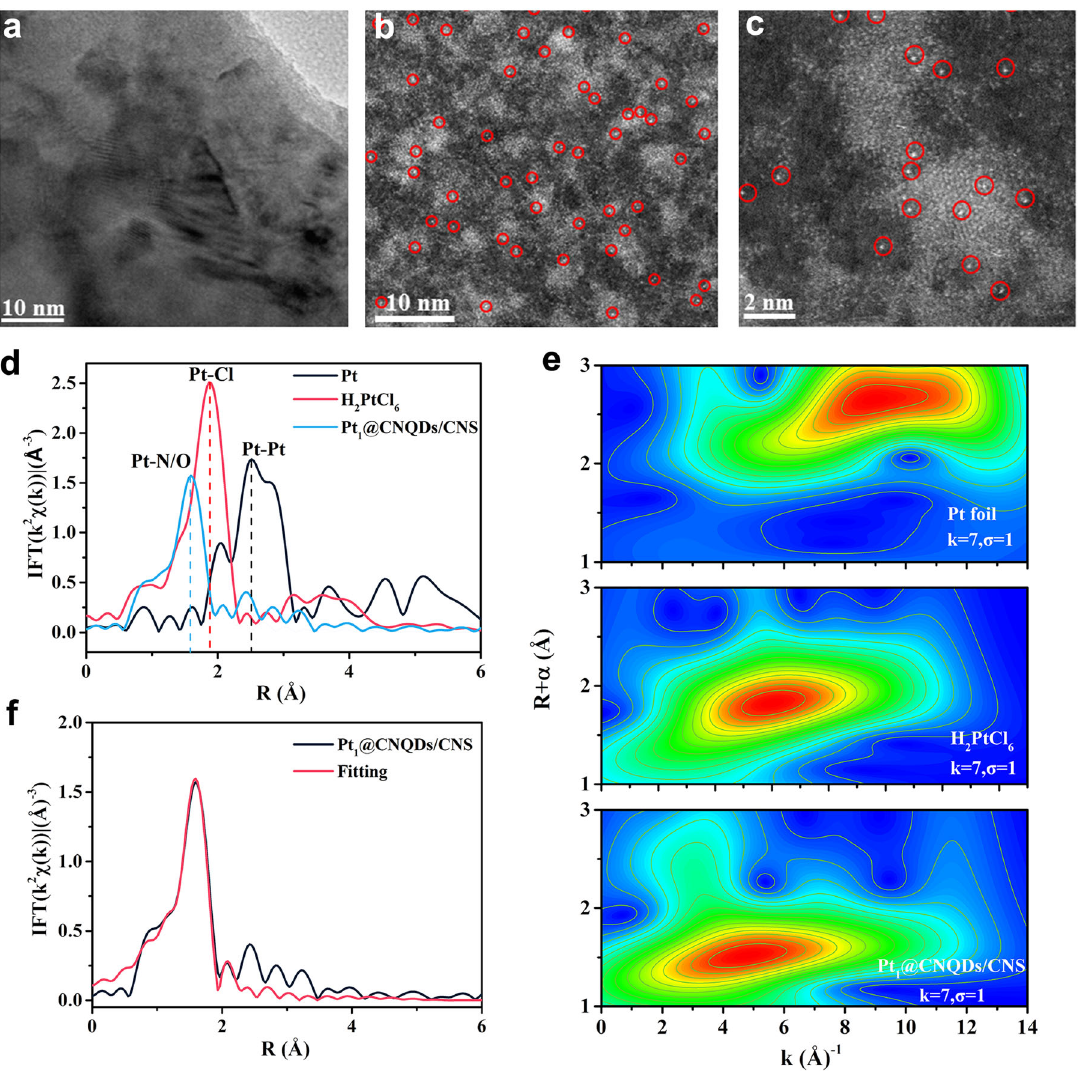
Fig. 2 Structural characterizations of Pt 1 @CNQDs/CNS. a HRTEM image and b , c AC HAADF-STEM images of the Pt 1 @CNQDs/CNS at the scale of 10 and 2 nm. d FT-EXAFS spectra and e WT-EXAFS spectra of the Pt L 3 -edge of the Pt foil, H 2 PtCl 6 , and Pt 1 @CNQDs/CNS. f The corresponding EXAFS R space fi tting curves of the Pt 1